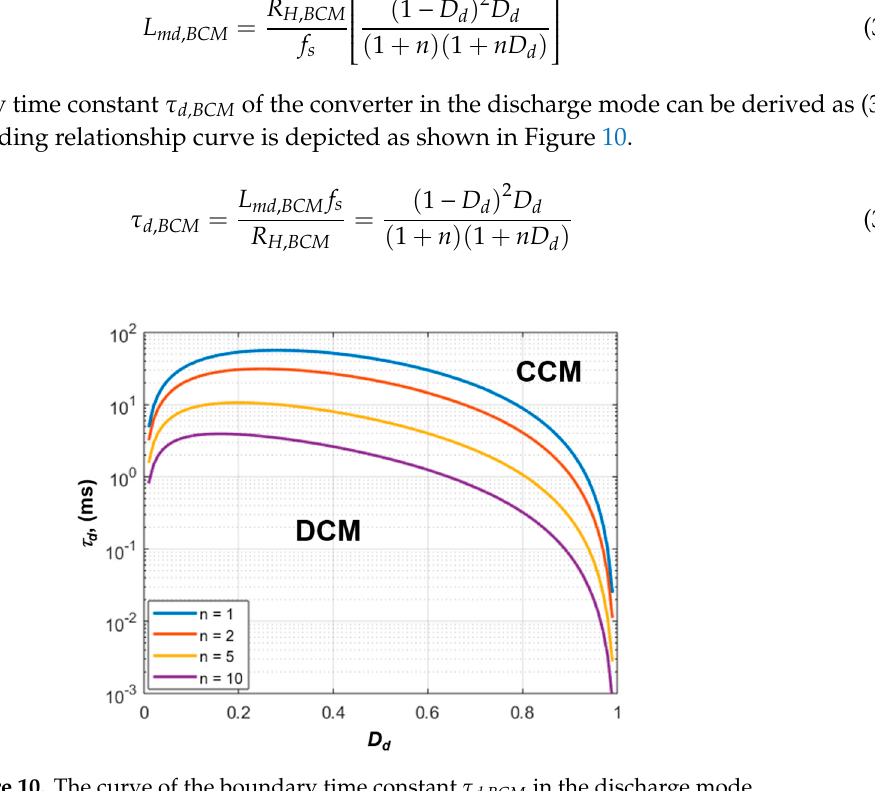
Figure 10. The curve of the boundary time constant τ d,BCM in the discharge mode.